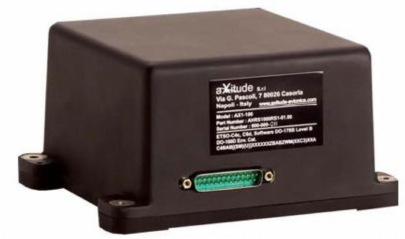
Figure 3. Axitude AX1-[ ] TM